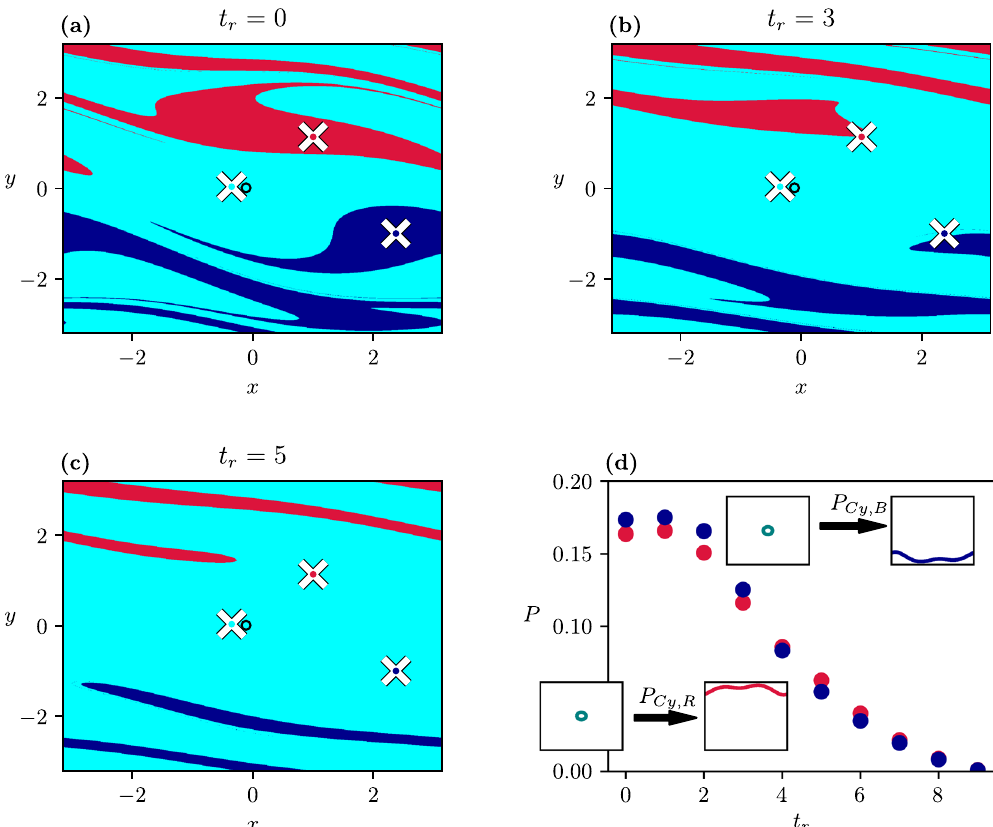
Figure 2. Scenario-dependent basins of the three attractors (colored dots within white crosses) belonging to C + = 0.33 with scenarios starting at t − = 0, C − = 0.1 and ending at C + = 0.33 ( I 1 ) by t + = 40 for different ramping times: t r = 0 ( a ), 3 ( b ), and 5 ( c ). The cyan attractor belonging to C − is marked by a black circle in the cyan background. ( d ) Dependence of the tipping probabilities P Cy , B and P Cy , R on t r with a visual illustration of the switch between attractors due to the tipping transitions (insets). The dots representing the tipping probability values are coloured, here and in the following, with the colour of the attractor in the bifurcation diagram of Fig. 1a into which tipping